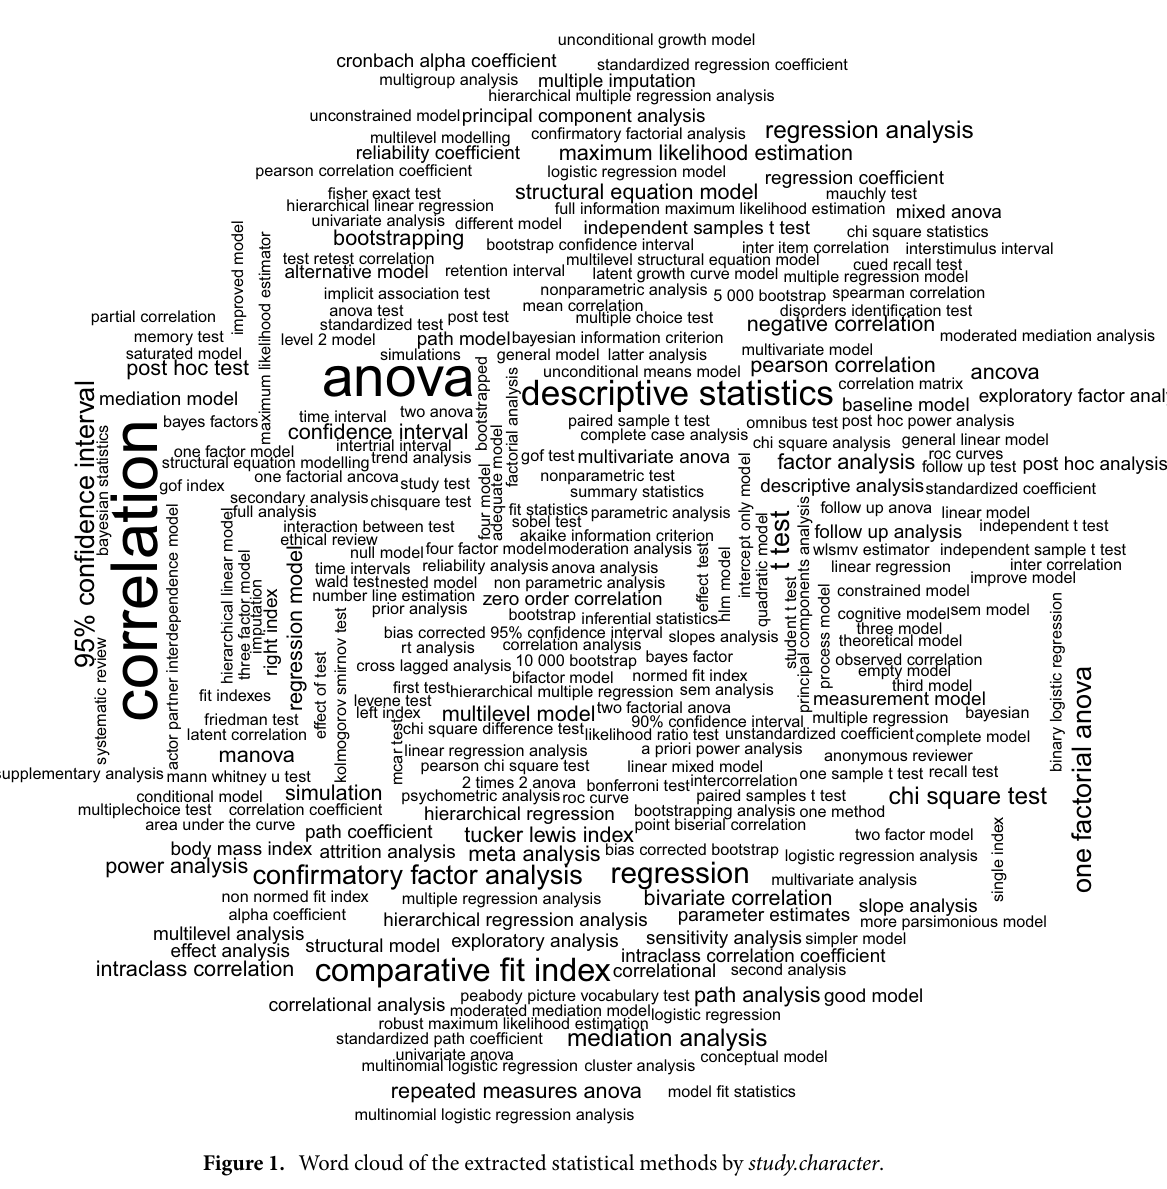
Figure 1. Word cloud of the extracted statistical methods by study.character